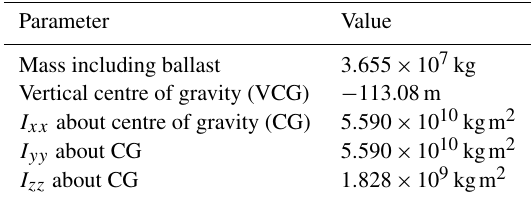
Table 2. WindCrete substructure